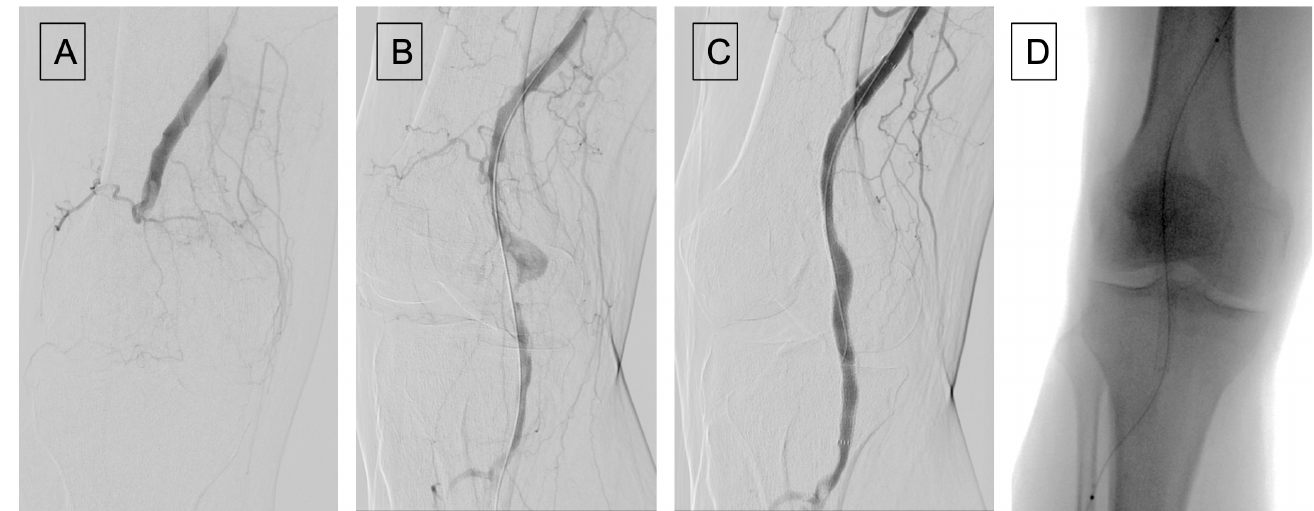
Figure 2. ( A ) Angiography showing a popliteal artery aneurysm thrombosis; ( B ) after recanalization using a thrombo-embolectomy system (Indigo catheter from Penumbra); ( C ) angiographic control after Viabahn placement, pointing out a distal popliteal residual non occlusive thrombosis. ( D ) Placement of Cragg-McNamara catheter for local fibrinolysis.